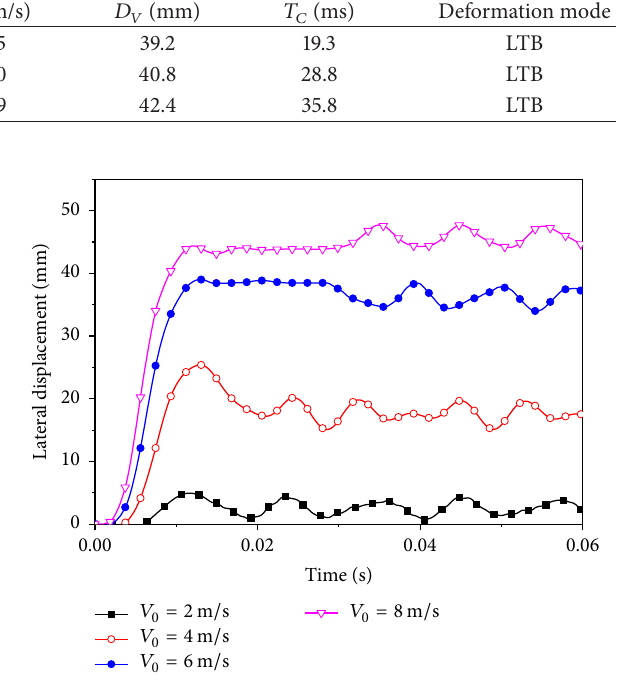
Figure 29: Lateral displacement of mid-span of beam under differ- ent impact